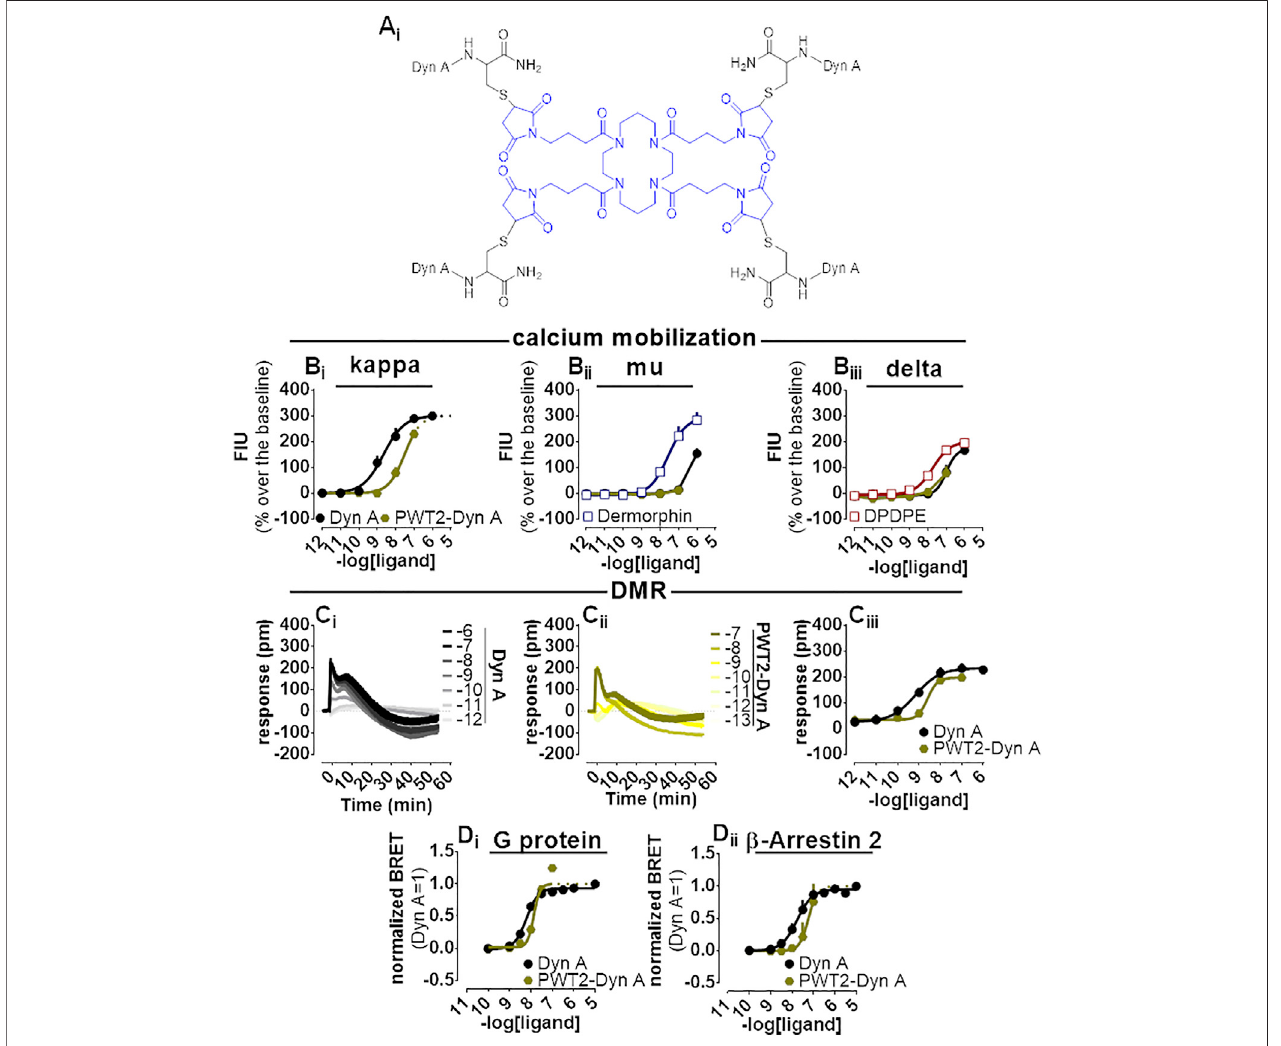
FIGURE 5 | Pharmacological characterization of PWT2-Dyn A. Molecular structure (A i ) . Calcium mobilization experiments in CHO stably expressing the human kappa (B) ,mu (Bii)i and delta (Bii) opioidreceptor andchimericGproteins, concentration-responsecurvestoDyn Aand PWT2-DynA.AveragedDMR traces obtained in CHO cells stably expressing the human kappa opioid for increasing concentration of Dyn A (C i ) and PWT2-Dyn A (C ii ) , with corresponding concentration-response curves (C iii ) . Concentration response curves to Dyn A and PWT2-Dyn A performed with a BRET assay on SH-SY5Y cells stably expressing the human kappa opioid-RLuc tagged receptor together with either the G β 1 -RGFP (D i ) or the β -Arrestin 2-RGFP fusoprotein (D ii ) . Data are mean +sem of three to six independent experiments performed in